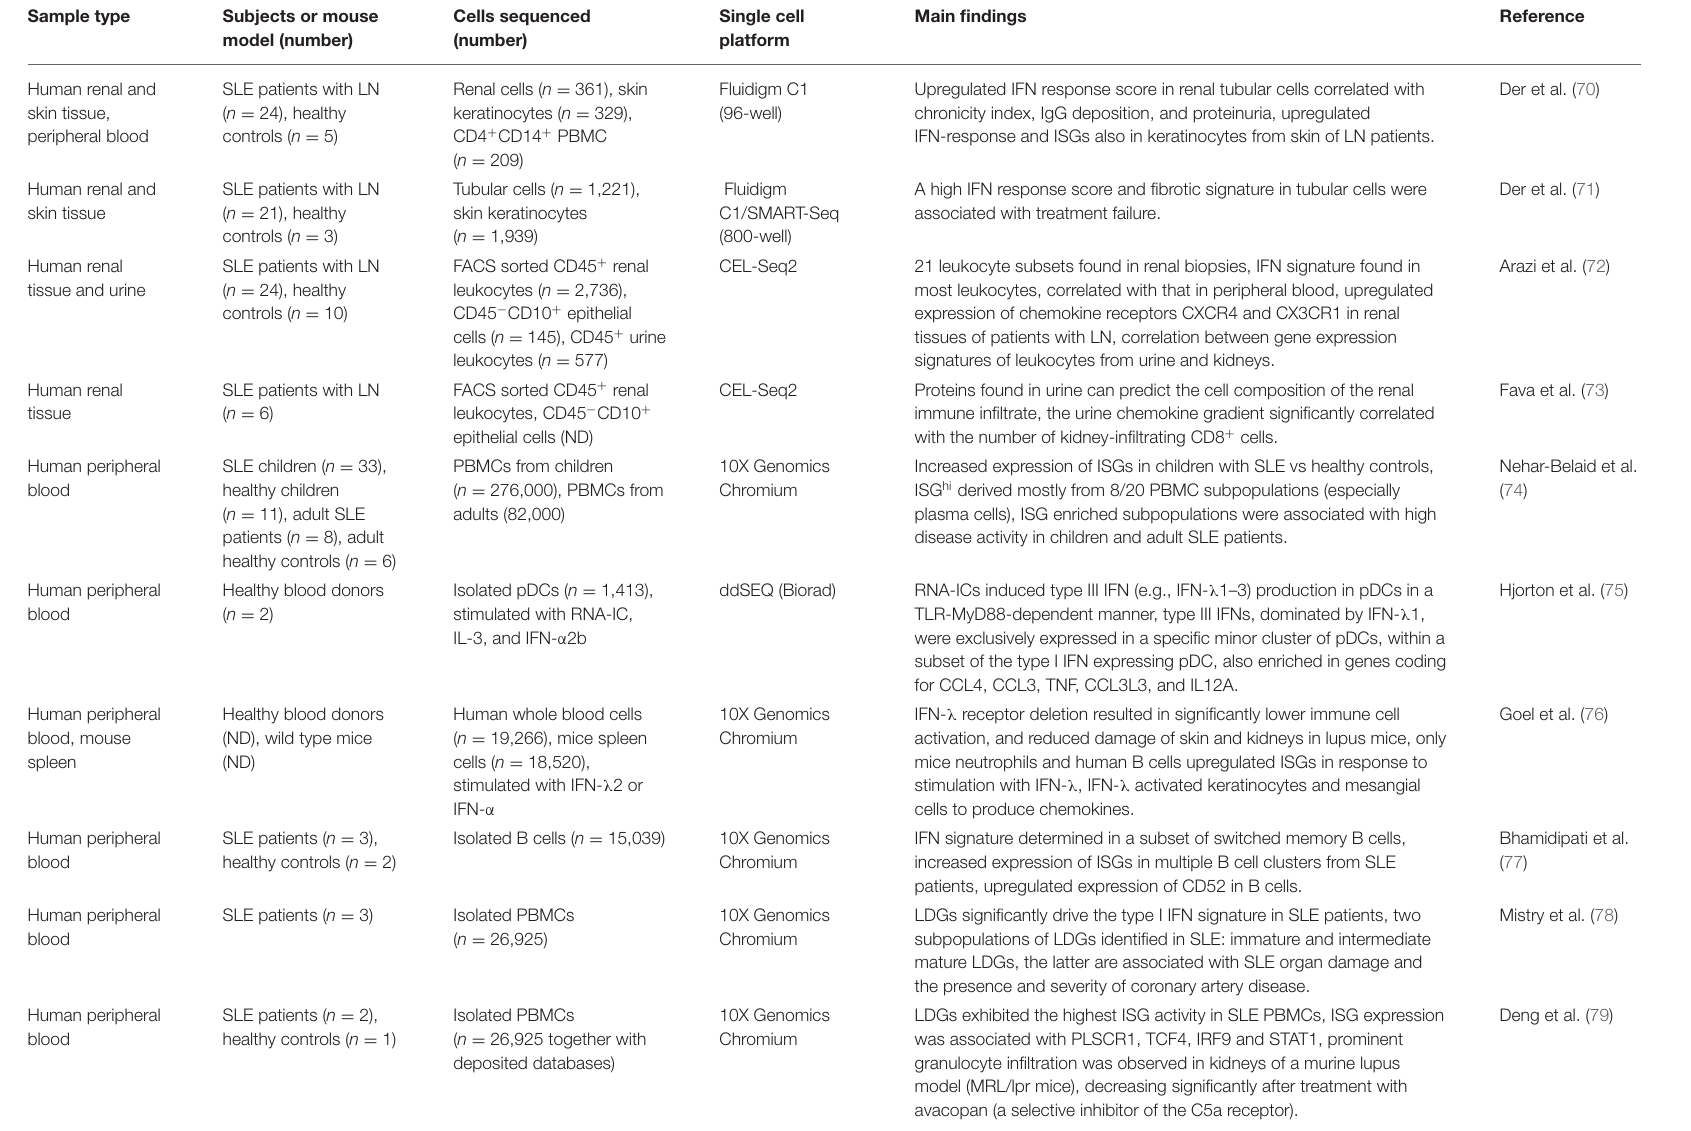
TABLE 2 | Application of scRNA-seq technology in systemic lupus erythematosus. Sample